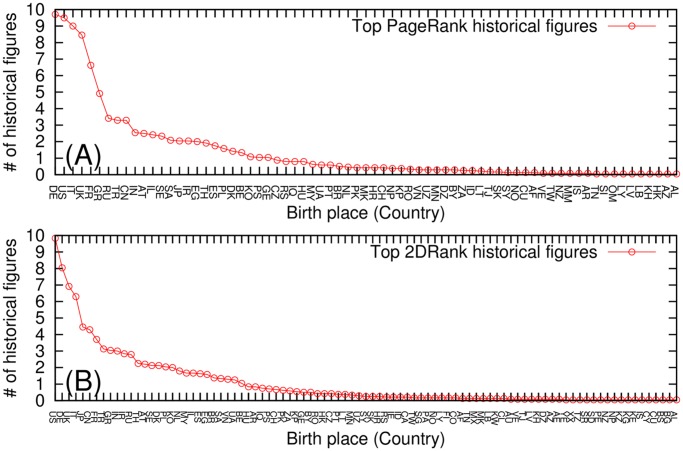
Birth place distribution of top historical figures averaged over 24 Wikipedia edition for (A) PageRank historical figures (71 countries) and (B) 2DRank historical figures (91 countries).Two letter country codes are represented in Table 3.